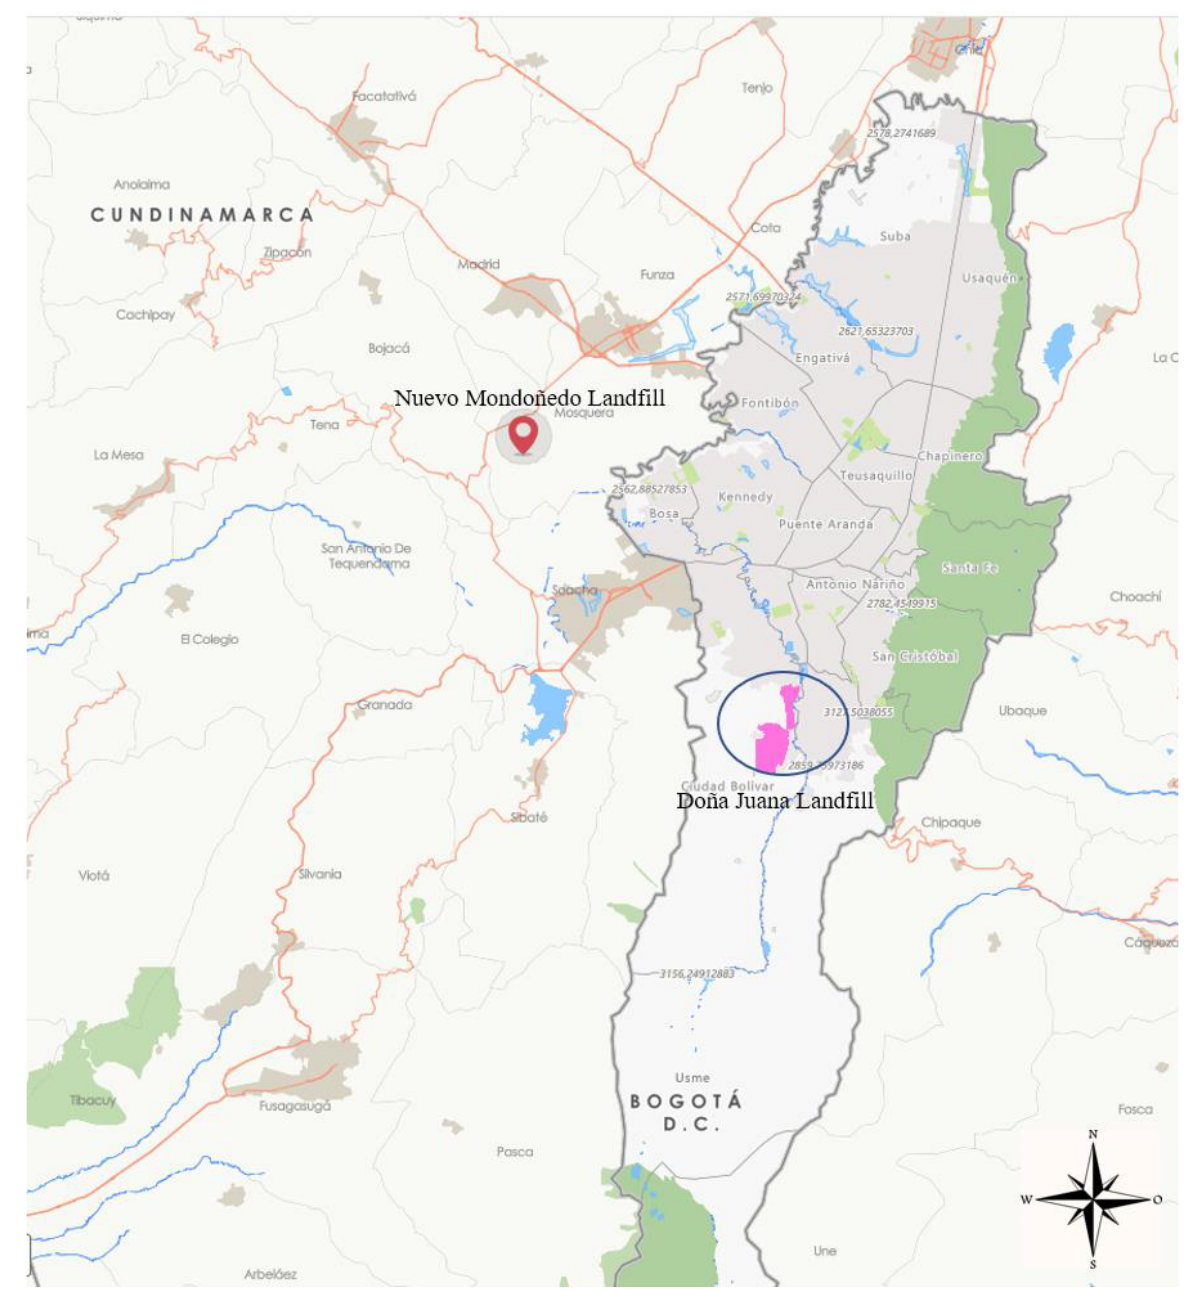
Figure 10. Location map of work distance 1 (Doña Juana landfill) and work distance 2 (Nuevo Mondoñedo landfill location zone)